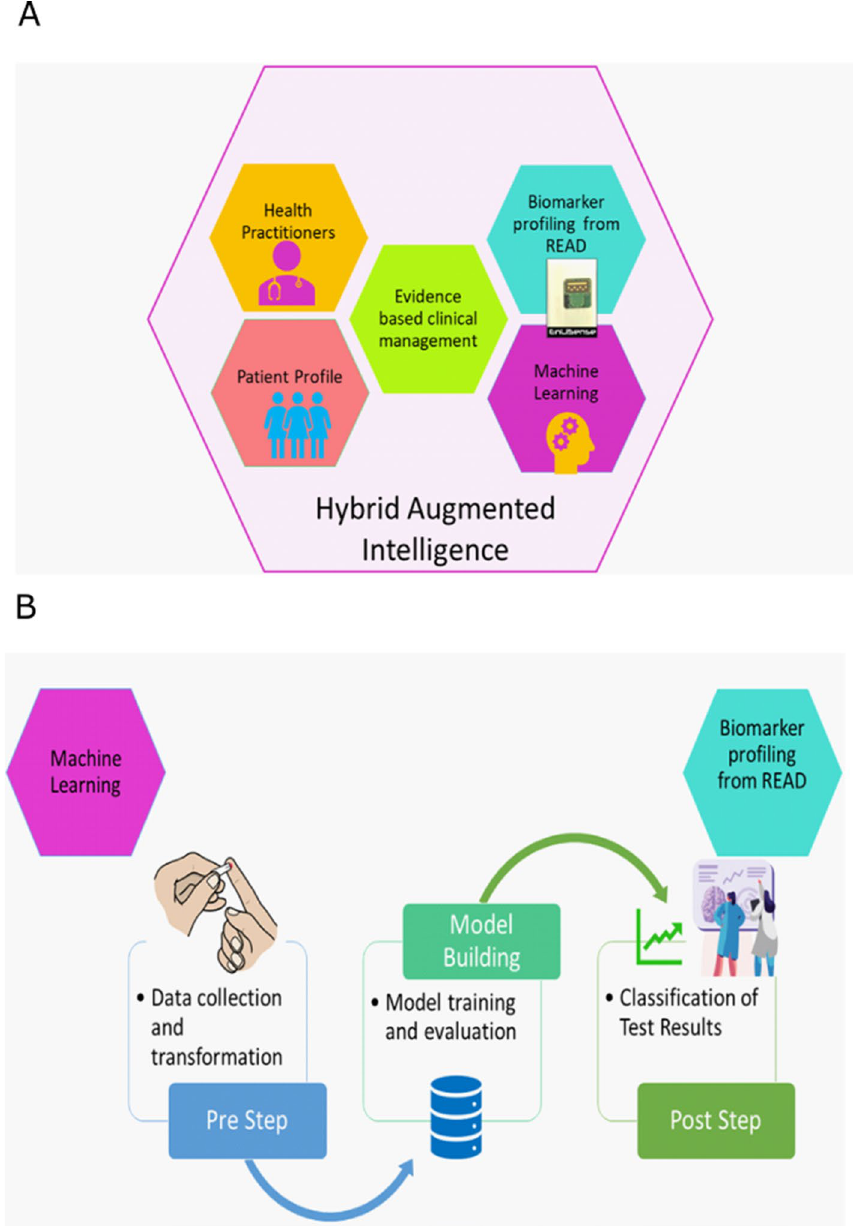
Figure 1. ( A ) Hybrid augmented intelligence approach, ( B ) Machine learning model building process